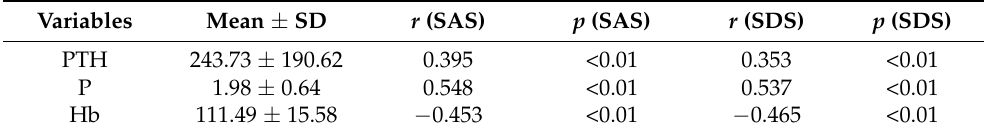
Table 1. Pearson correlation analysis between SAS/SDS score and laboratory tests in the MHD patients (N = 180).